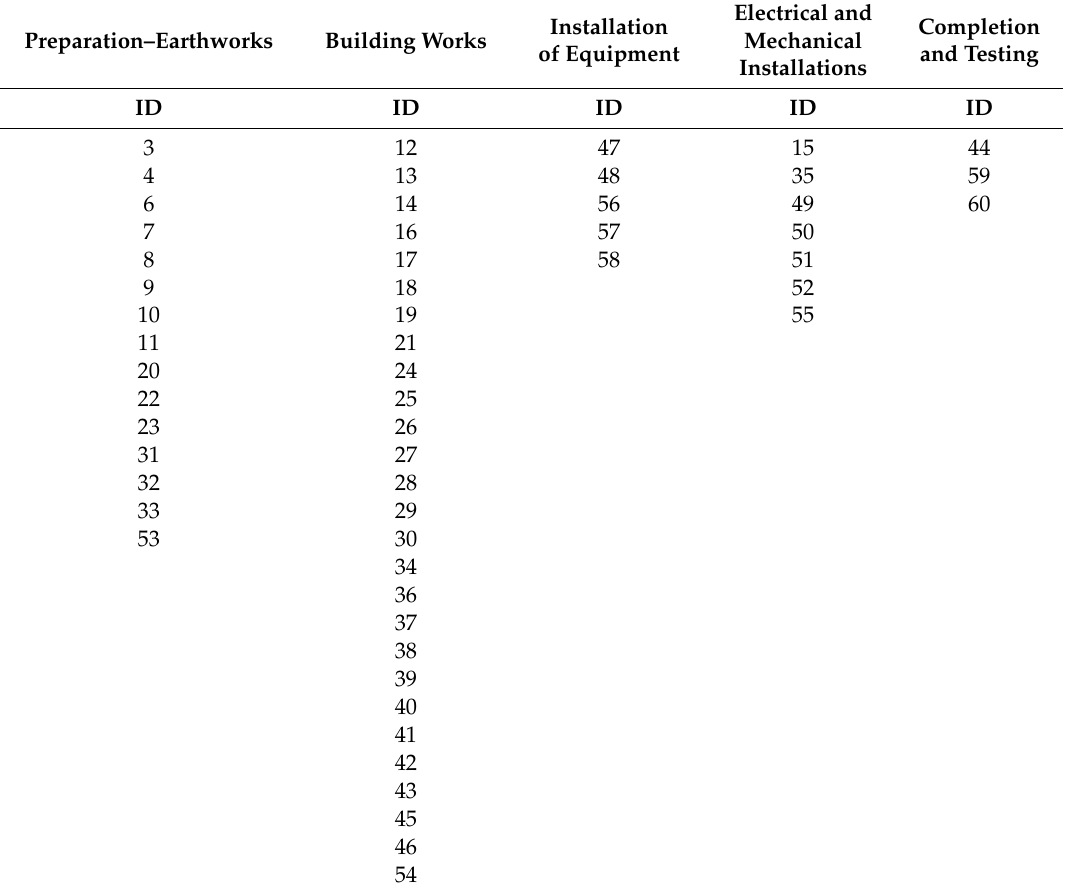
Table 2. Categorization of